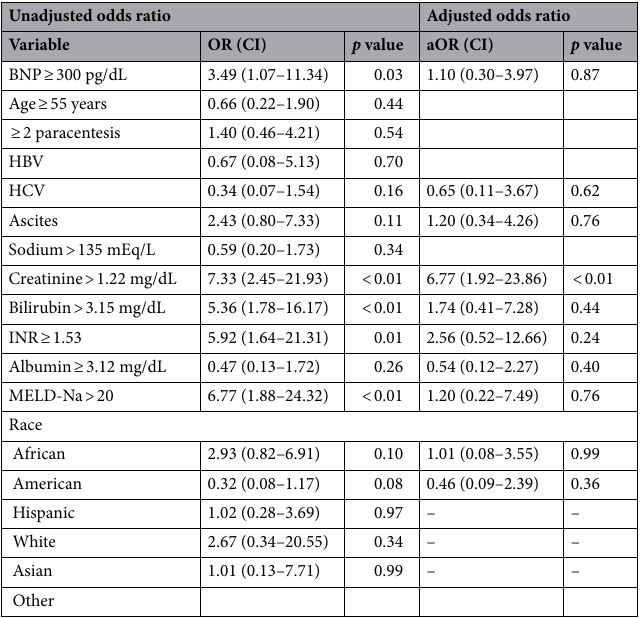
Table 3. Univariate and multivariate Cox regression analysis for 90-day Mortality. CI confidence interval, BNP brain natriuretic peptide, HBV hepatitis B, HCV hepatitis C.